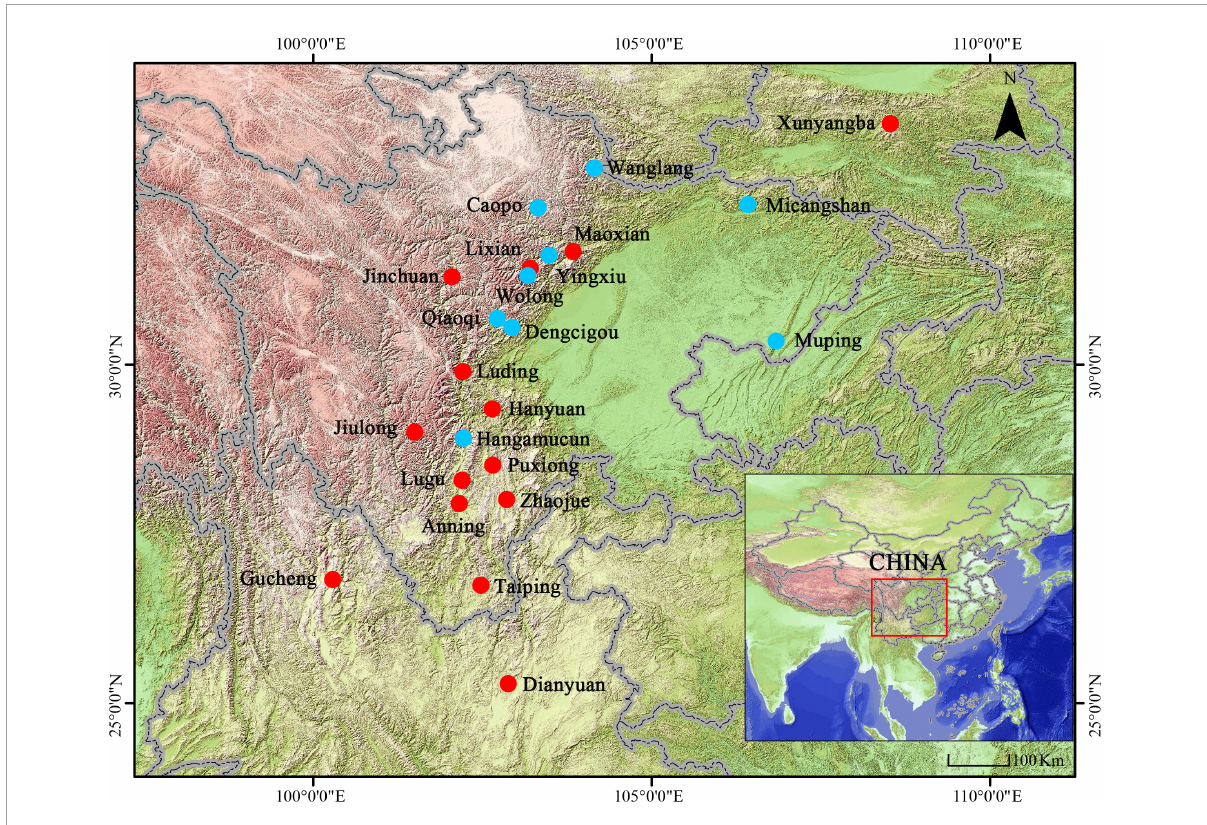
FIGURE1 Map depicting the study sites for 24 Bufo andrewsi populations. Red circles indicate sampling sites in this time and blue circles indicate sampling sites in published papers.